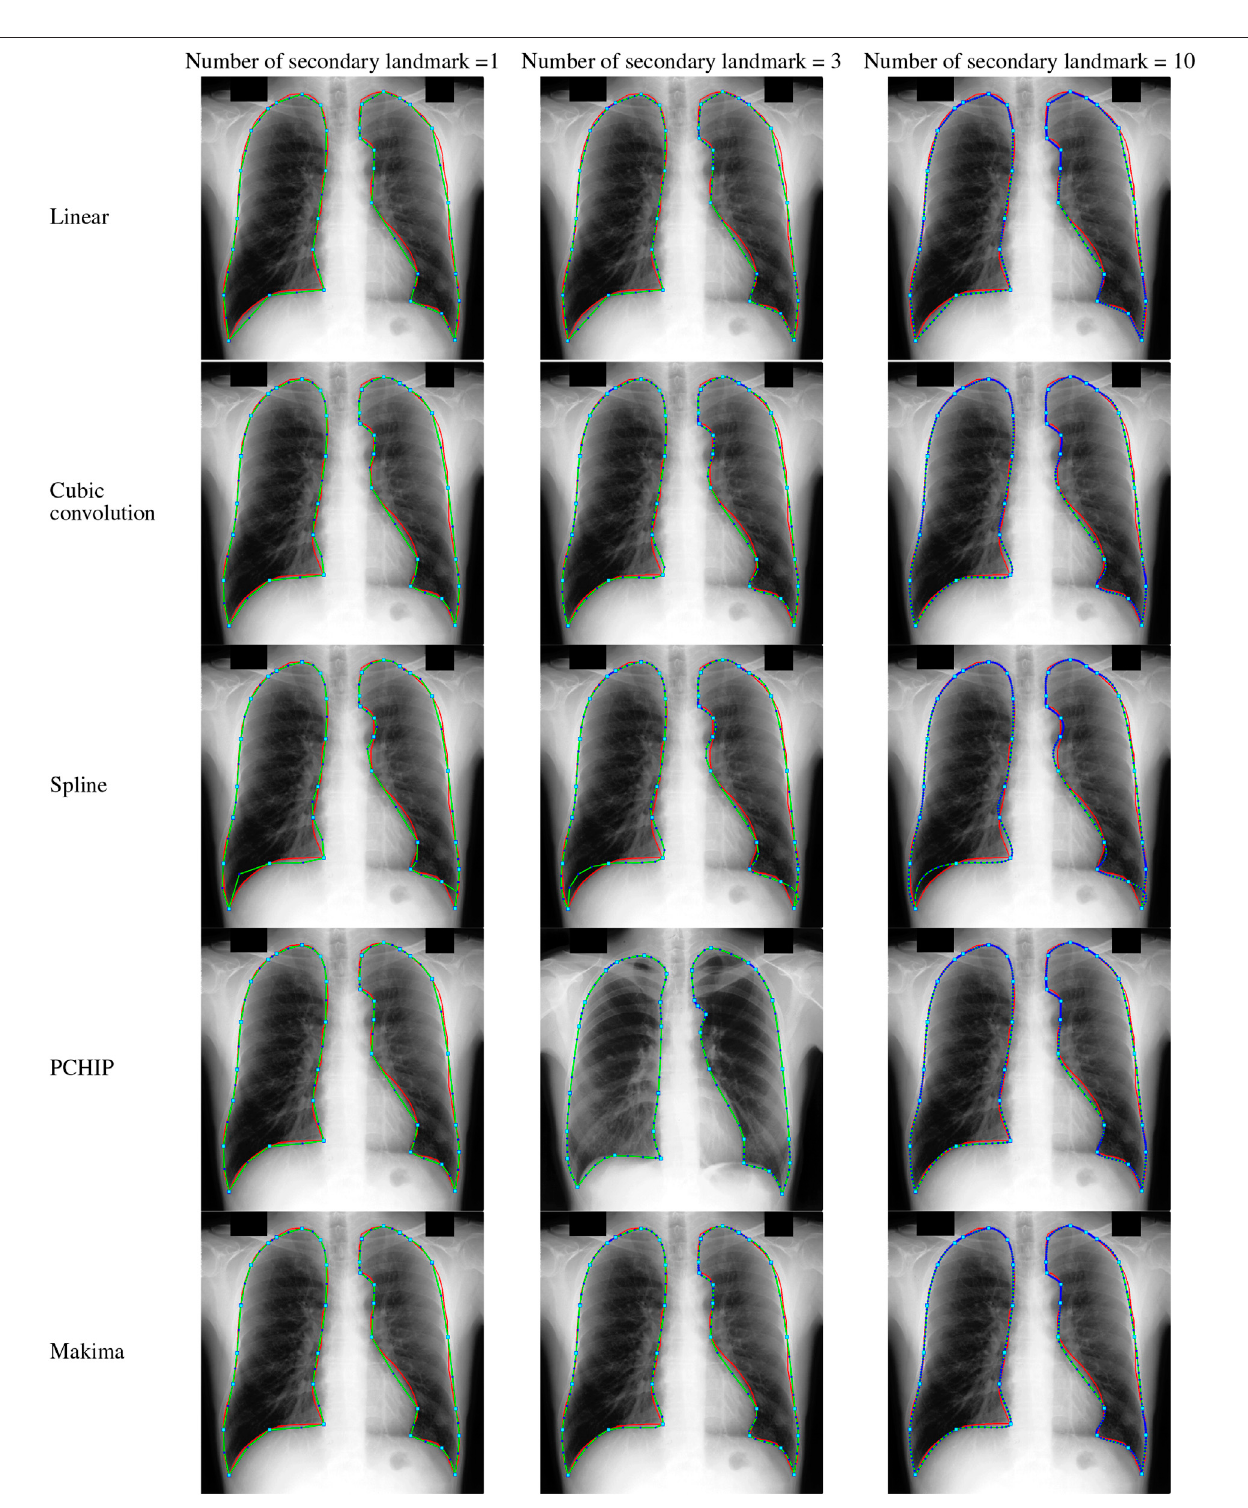
FIGURE 4 | Lungs region formation: ground truth (red) and the modeled shape (green) using different interpolating polynomials with 1, 3, and 10 intermediate semilandmark point(s) of the selected image dataset JPCLN083.